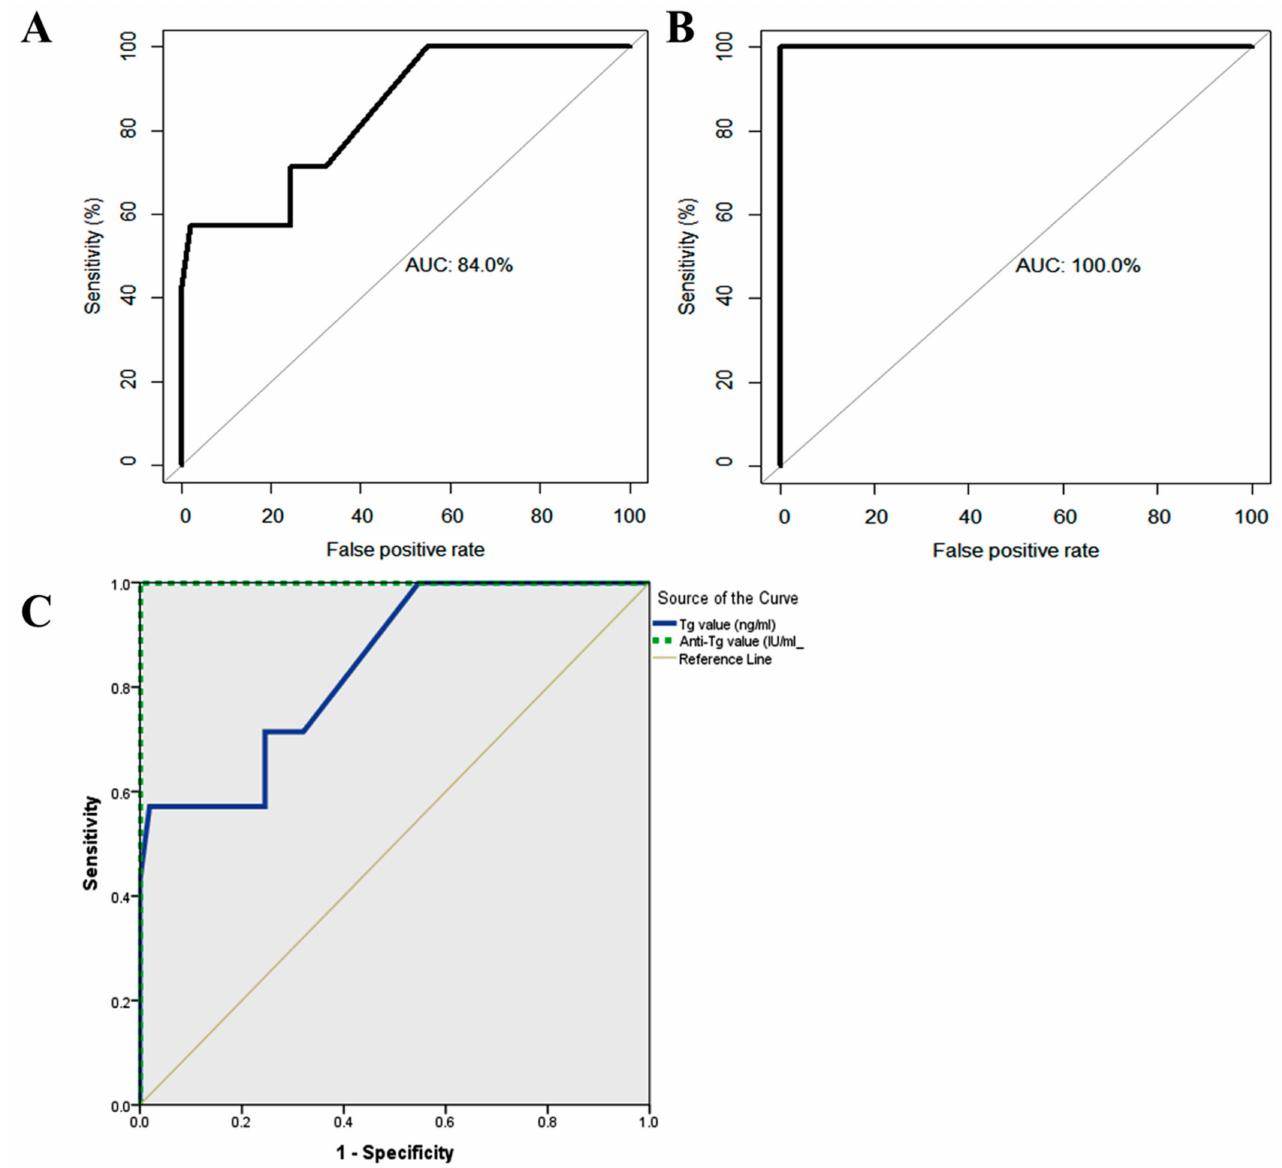
Figure 3. ( A) Predictive performance of TG values for relapse outcome in patients with thyroid cancer. ( B ) Predictive performance of anti-TG for relapse outcomes in patients with thyroid cancer. ( C ) Comparison of the predictive performance of TG and anti-TG for relapse